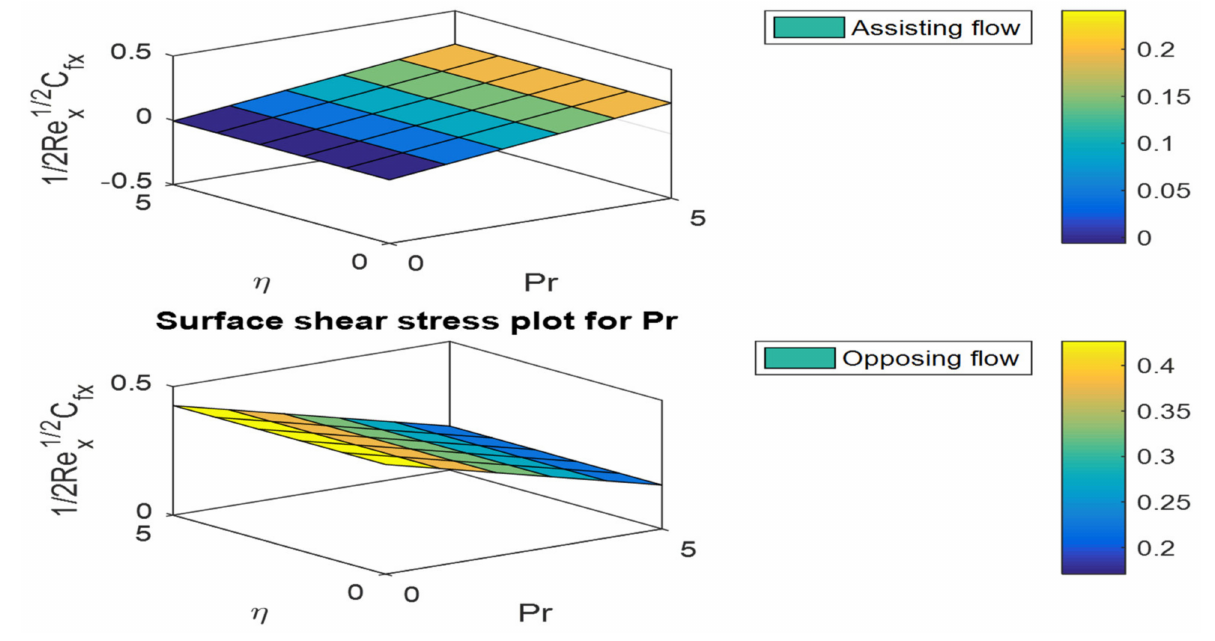
Figure 28. Surface plots for the f (cid:48)(cid:48) ( 0 ) for dissimilar values of Pr.